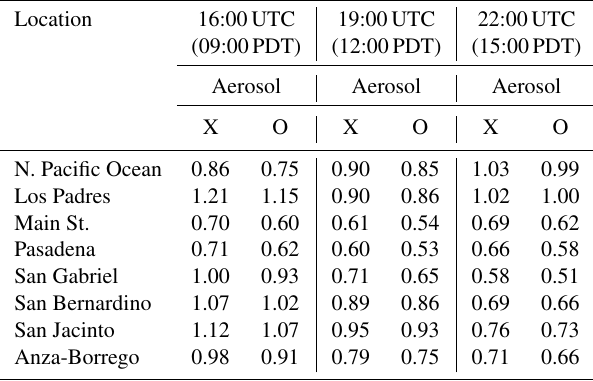
Table 2. Summary of air mass factors at eight locations at